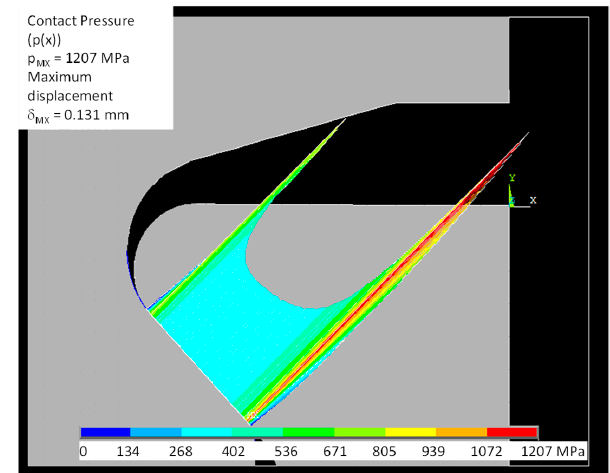
Figure 10. FEM model of test # 2: contact pressure.